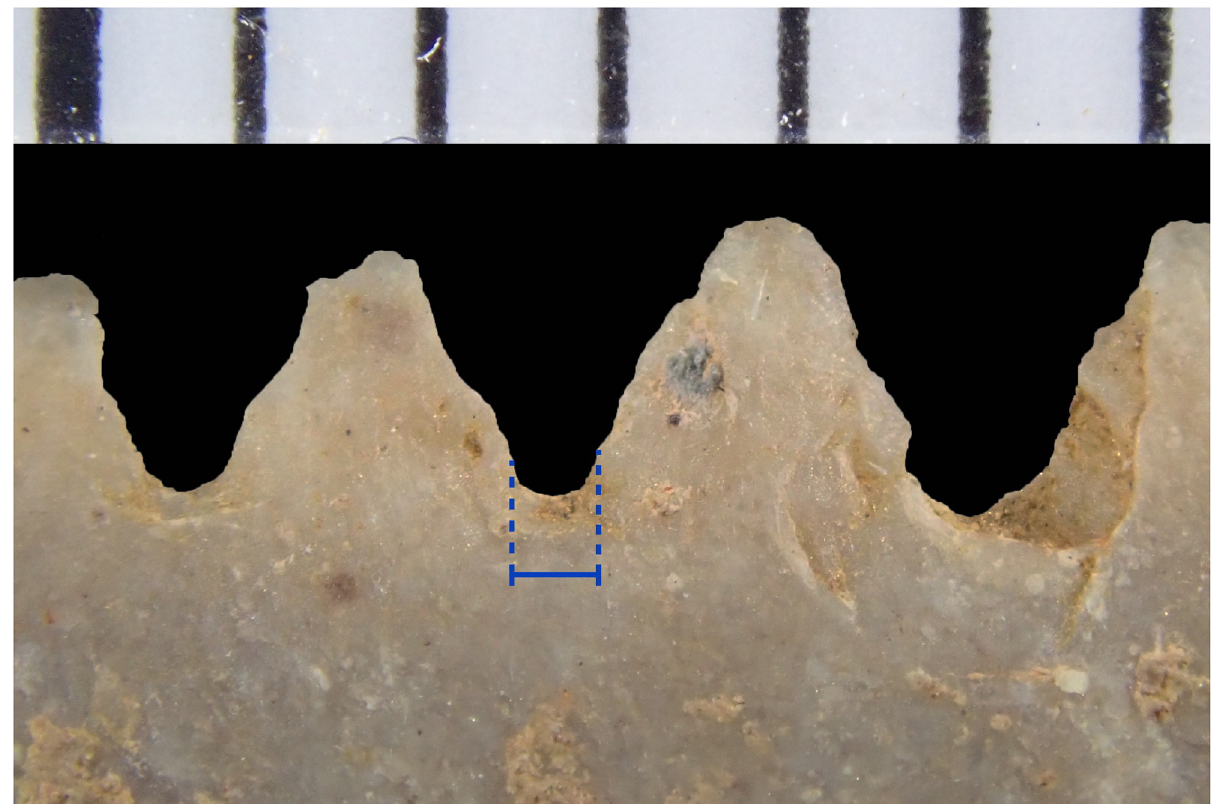
Fig 18. Denticulation scar platforms. The platform width of the denticulation scars (indicated by blue lines; see Table 2) was measured as a proxy for the maximum width of the tip of the notching tool. Scale bar is marked in 1 mm increments.